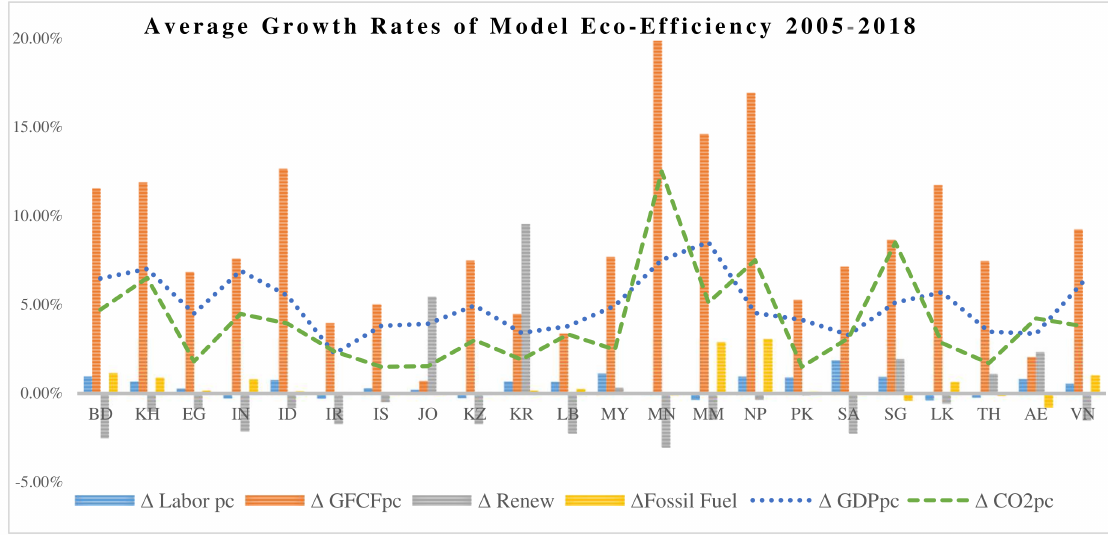
Figure 3. Average growth rates of the Eco-Efficiency indicator and their drivers for the 22 Asian economies.